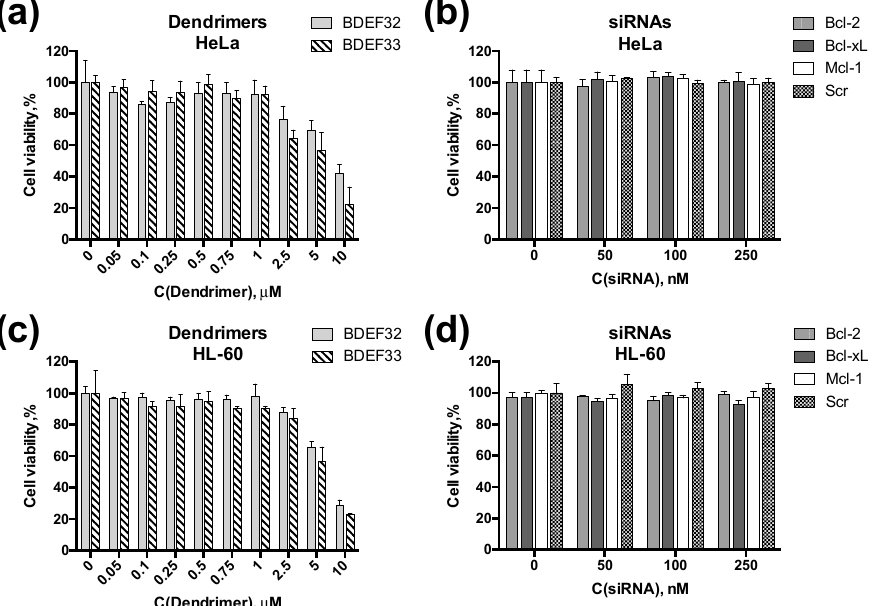
Figure 7. Cytotoxicities of dendrimers and siRNAs. Viability of HeLa cells treated with ( a ) dendrimers BDEF32 and BDEF33; or ( b ) pro-apoptotic siRNAs, as measured by the MTT assay. Viability of HL-60 cells treated with ( c ) dendrimers BDEF32 and BDEF33; or ( d ) pro-apoptotic siRNAs measured by spectrofluorimetric resazurin assay (SRA). The viability of the cells was evaluated (% relative to the negative control) after 72 h incubation with dendrimers and siRNAs.